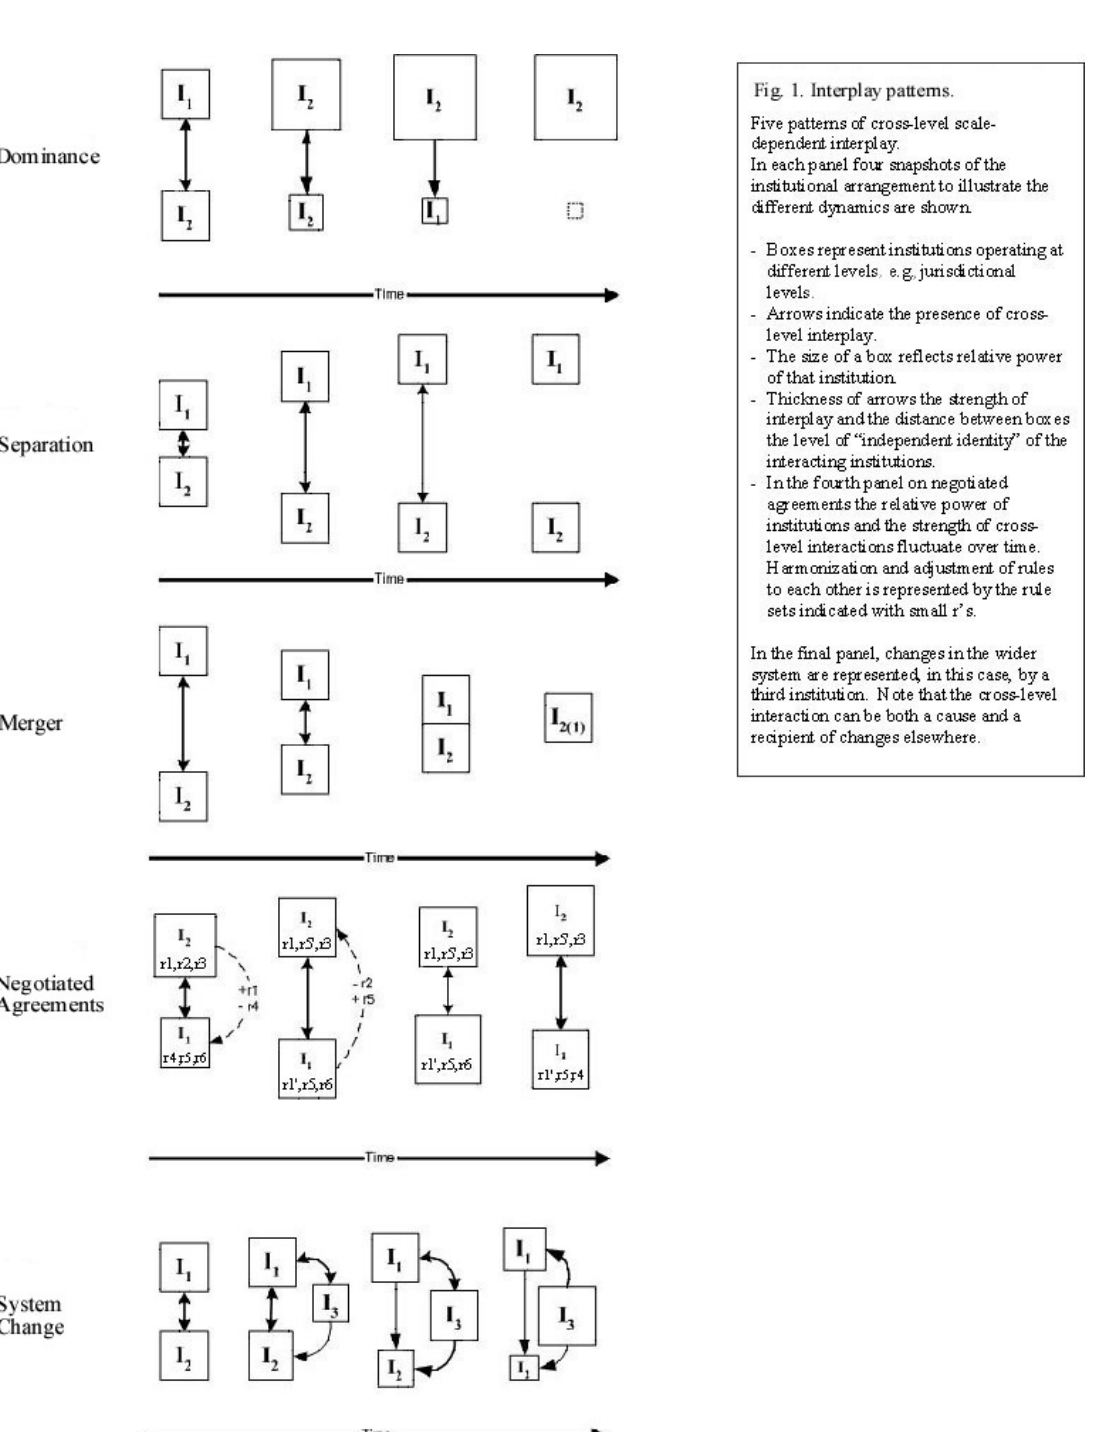
Fig. 1 . Interplay